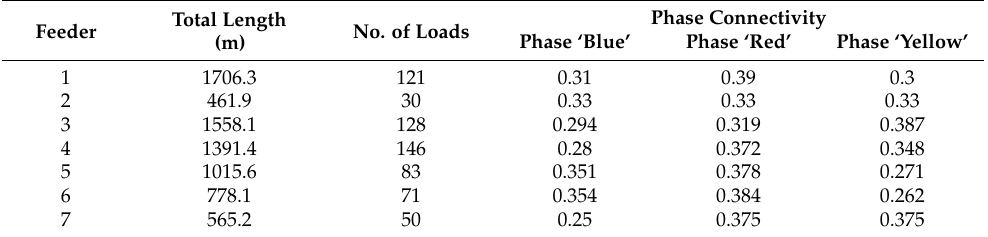
Figure 3. The real-life Maltese LV network with seven feeders. Table 2. Main characteristics of LV Networks.